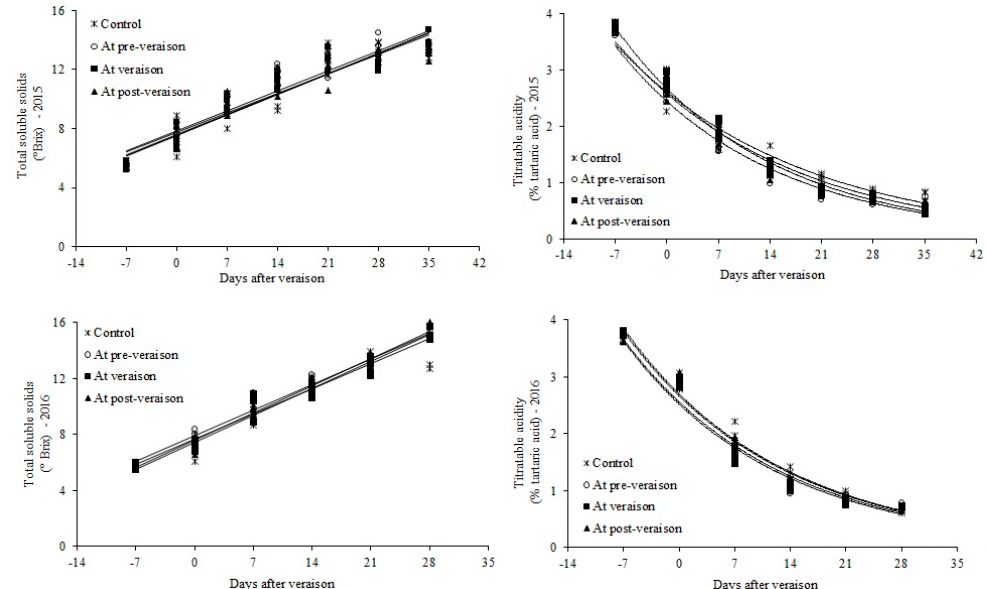
Figure 4. Evolution of total soluble solids (TSS; Brix) and titratable acidity (% tartaric acid) of ‘Benitaka’ berries ( Vitis vinifera L.) subjected to (S)-cis -abscisic acid ( S -ABA 400 mg L − 1 ) at different timings of veraison. A second application of S -ABA 400 mg L − 1 was performed for all treatments 10 days after the first application, except for the control. Data were originated from polynomial regression.